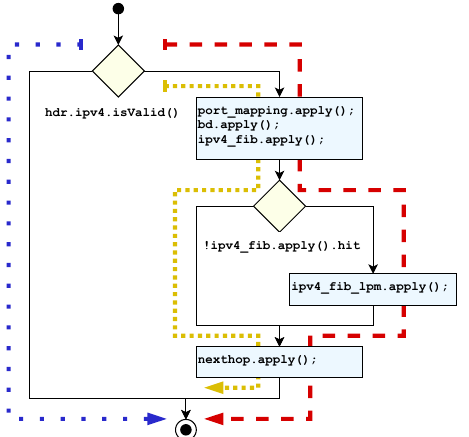
Figure 3. High-level control flow of Listing